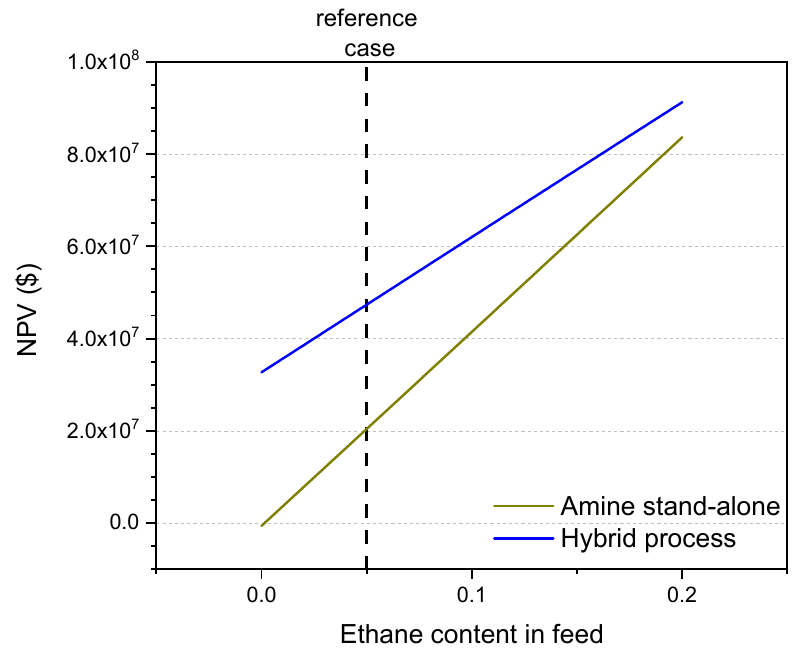
Figure 10. Effect of ethane content on the feasibility of the hybrid process (blue line) and the amine stand-alone process (dark yellow line). The reference case is shown.